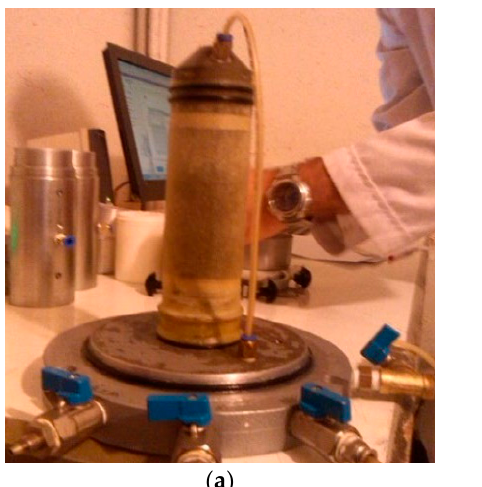
Table 2. Summary of the static triaxial tests conducted during the current